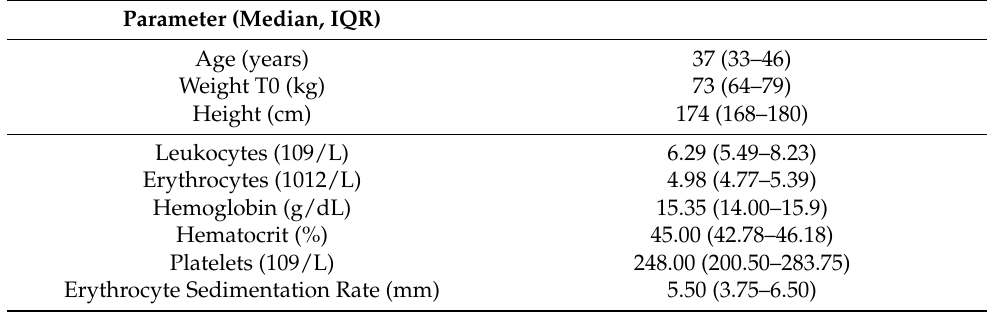
Table 1. Subjects’ anthropometric data and hematological parameters determined at the